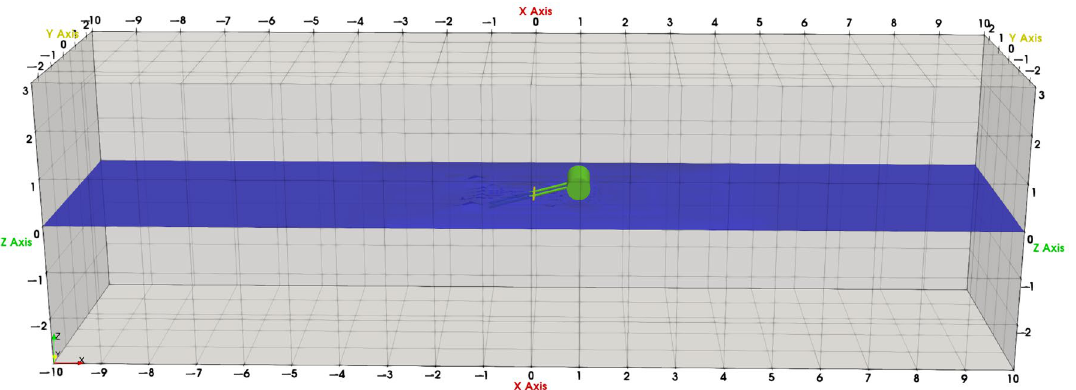
Figure 1. NWT for the simulation with a buoy with a 0.25 m radius (R). Wave propagation is in the direction of the positive x -axis, the free surface elevation coincides with the z direction, and the length of the buoy is in the y direction. The wave gauges are placed from − 10 to 10 in the x direction at y = 0